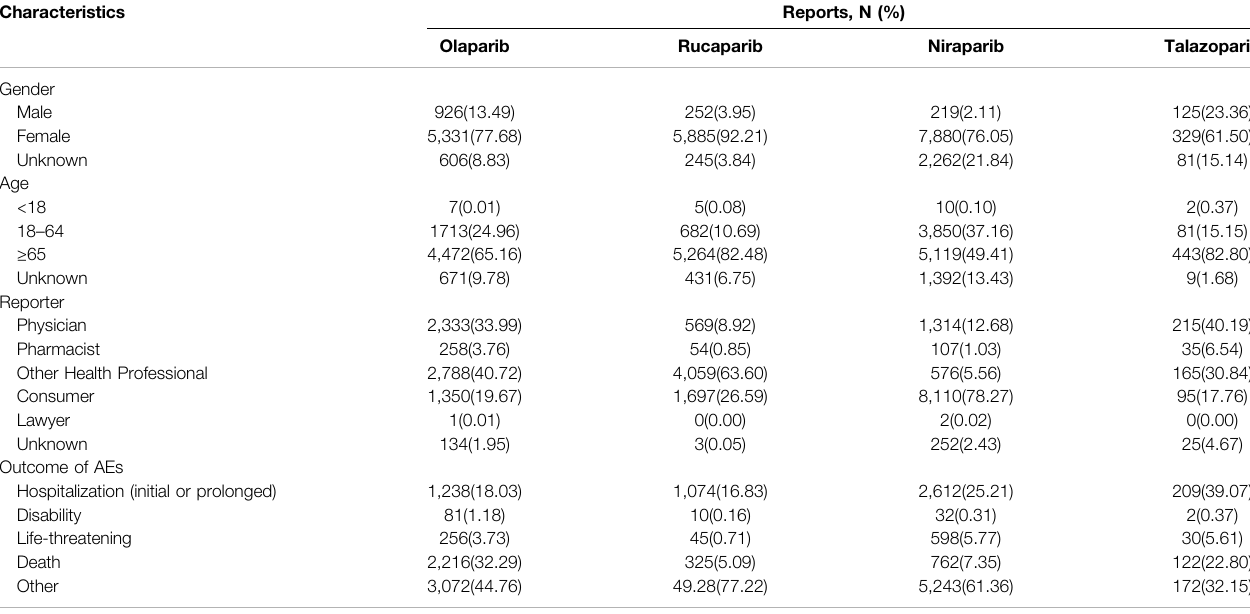
TABLE 2 | Clinical characteristics of patients with PARPi AEs from the FAERS database.